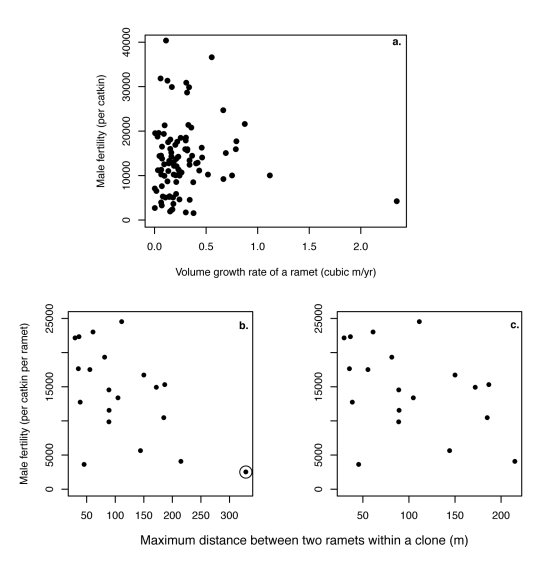
Male fertility and asexual fitness measures are not significantly related.(a) At the ramet level, there was no evidence for a trade-off between growth rate as measured by volume growth per year (m
3 per year) and ramet male fertility (r = 0.04, t = 0.388, df = 94, p = 0.70). (b) Although a correlation analysis between maximum distance between two ramets in a clone, Dmax, and the clone's mean male fertility was significant (r = −0.55, t = −2.762, df = 18, p = 0.013), this relationship was sensitive to the inclusion of a single data point (indicated by a circle). (c) Removing this point, the relationship is no longer significant (r = −0.40, t = −1.802, df = 17, p = 0.09).